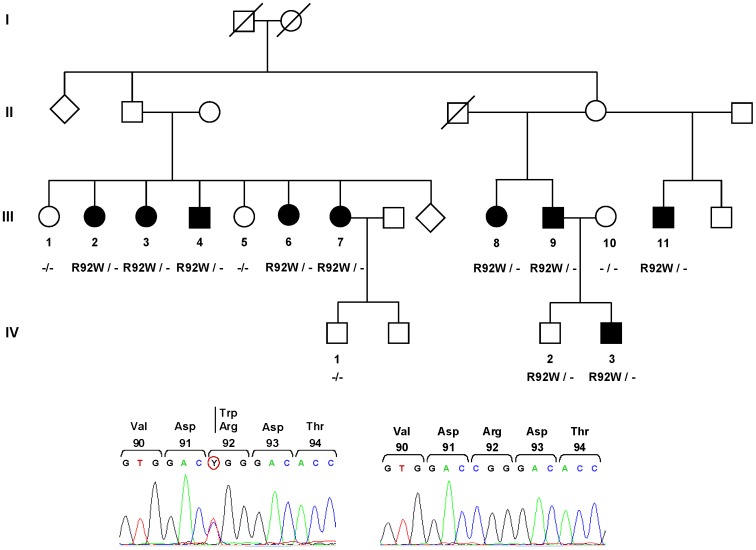
Genealogical tree and mutation analysis.Filled symbols represent patients with TRAPS; open squares and circles indicate healthy individuals. No clinical information was available for individuals from generations I and II. A sequencing chromatogram showing the mutation identified in family members III.2, III.3, III.4, III.6, III.7, III.8, III.9, III.11, IV.2, and IV.3 is presented below. The sequence in healthy relatives (III.1, III.5, III.10, IV.1) is shown as a control. The heterozygous transition generating the missense mutation is encircled.